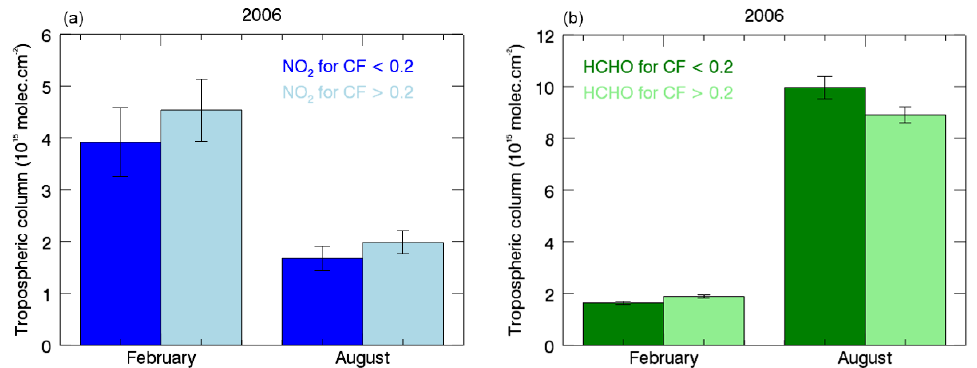
Figure 4. (a) Monthly mean tropospheric NO 2 columns simulated by TM5 for polluted grid cells (with all-sky monthly means > 1.0 × 10 15 moleculescm − 2 , n = 18 in February, n = 17 in August). The blue bars represent the average of the tropospheric NO 2 col- umn sampled on days when the OMI cloud fraction was smaller than 0.2. Light blue: average for columns sampled when OMI cloud fraction > 0.2. (b) Monthly mean TM5 HCHO columns for clear-sky and cloudy situations ( n = 18 in February, for August: all-sky monthly mean > 7.5 × 10 15 moleculescm − 2 , n =